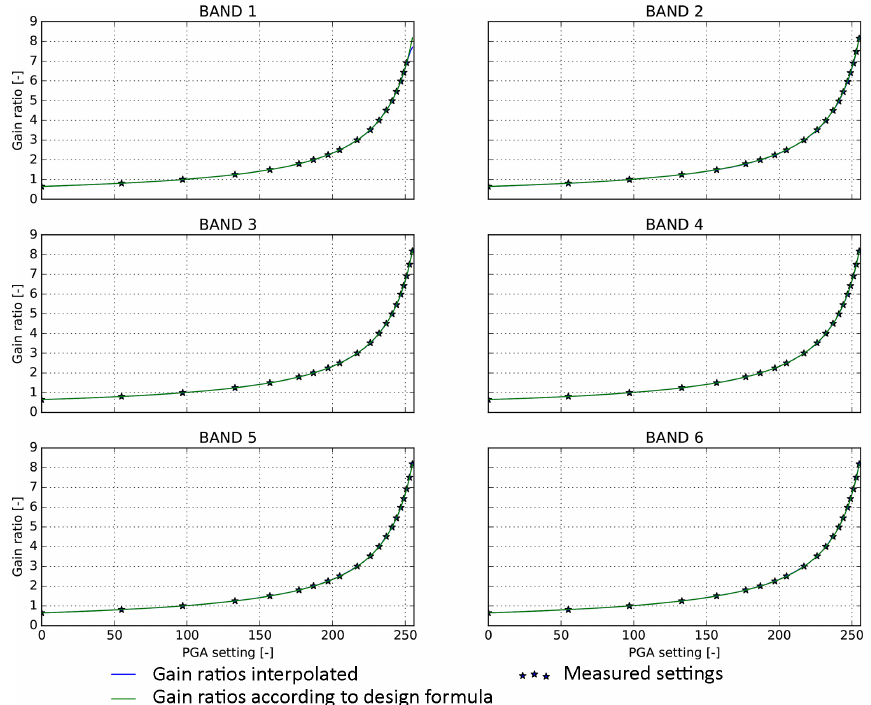
Figure 10. The obtained UVN gain ratio as a function of the PGA setting for even pixels and low CCD and CDS gain. Shown are the measured settings (stars), the interpolated gain ratio (blue curve), and the design formula by the supplier (green